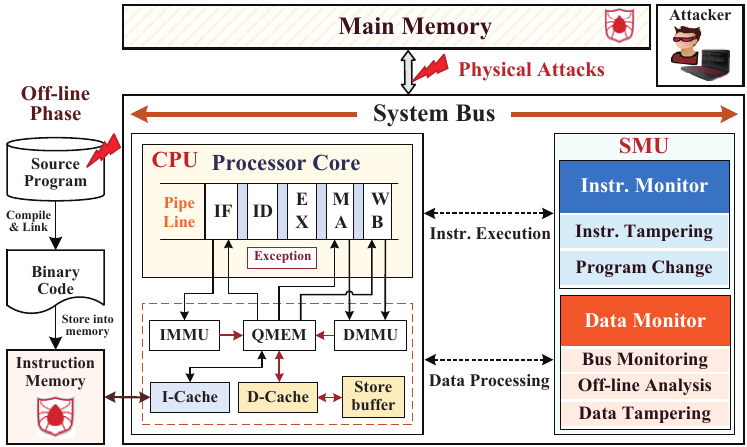
Figure 1. The SoC hardware architecture with integrating SMU for real-time security